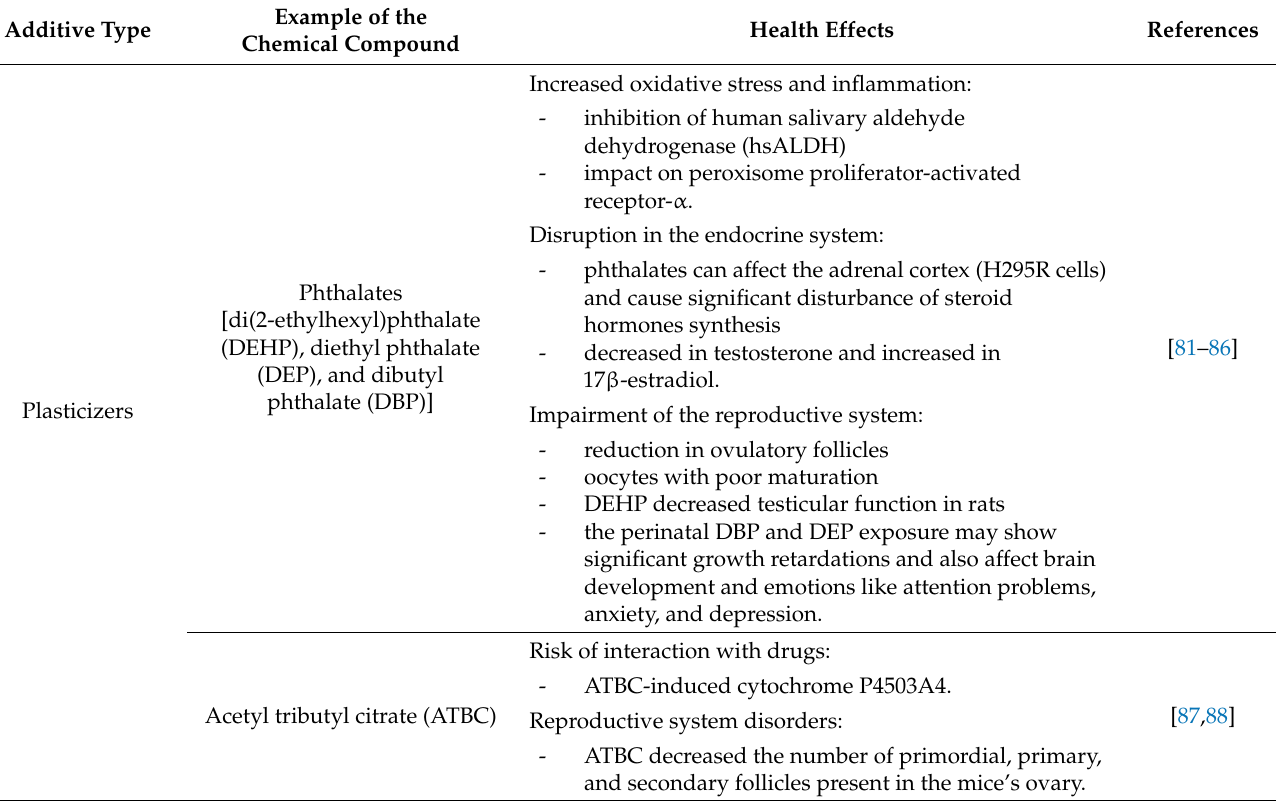
Table 3. Health effects of additives used in plastics